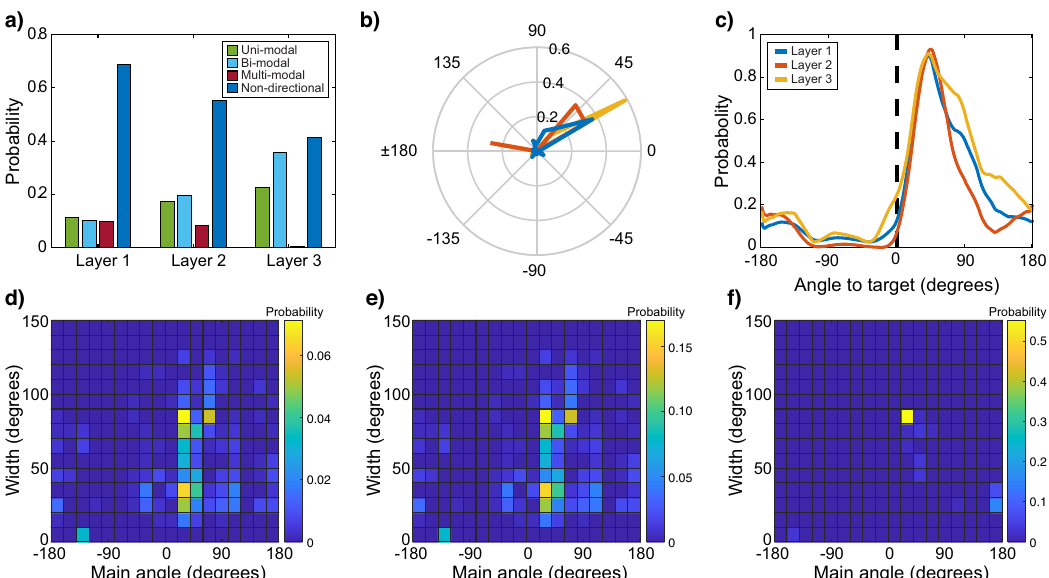
Fig. 3 Goal-direction neurons in navigation-net. a Neuron types in the three last layers of navigation-net (layers 1 to 3 have 4096, 1024, and 256 neurons, respectively). b The distribution of the peaks of the azimuth-dependent activation patterns of unimodal neurons in the last three layers (layers 1 to 3 in blue, red, and yellow lines, respectively). c The average of the azimuth-dependent activation distribution of unimodal units with peaks in the angle range with the highest probability (between 20 and 40 degrees in layers 1 and 3, and between 40 and 60 degrees in layers 2). This can be thought of as the average tuning curve of most of the unimodal neurons. d – f The 2D distribution of peaks and tuning widths of unimodal neurons in the fi rst ( d ), second ( e ), and third ( f ) layers of the